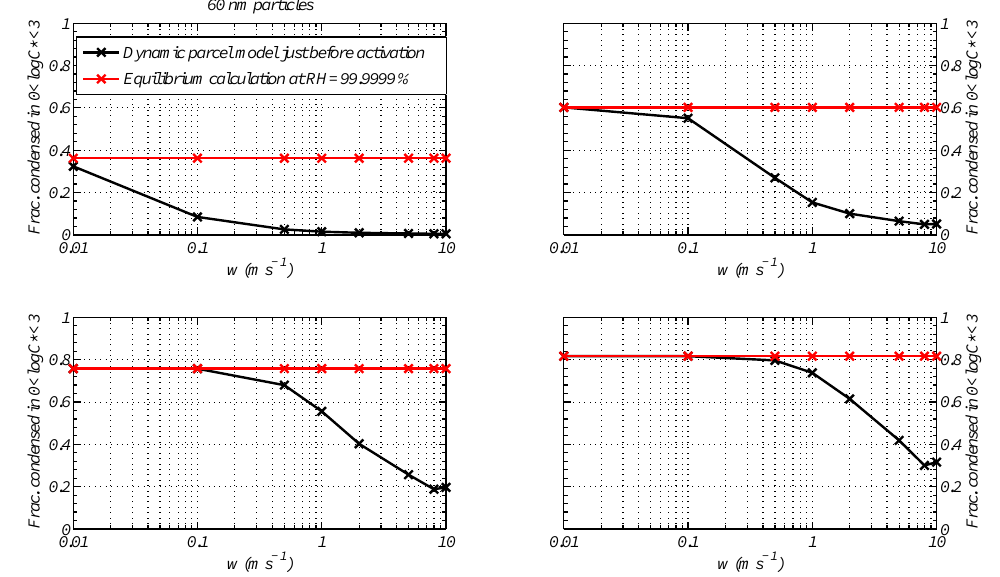
Fig. 3. Shows the fraction of condensed semi-volatiles in 1 ≤ C ∗ ≤ 1000µgm − 3 bins for the size distribution with parameters log σ = 0 . 5 and d m = 60nm. Top left is for N ap = 10cm − 3 , top right is for N ap = 100cm − 3 , bottom left is for N ap = 500cm − 3 bottom right is for N ap = 1000cm − 3